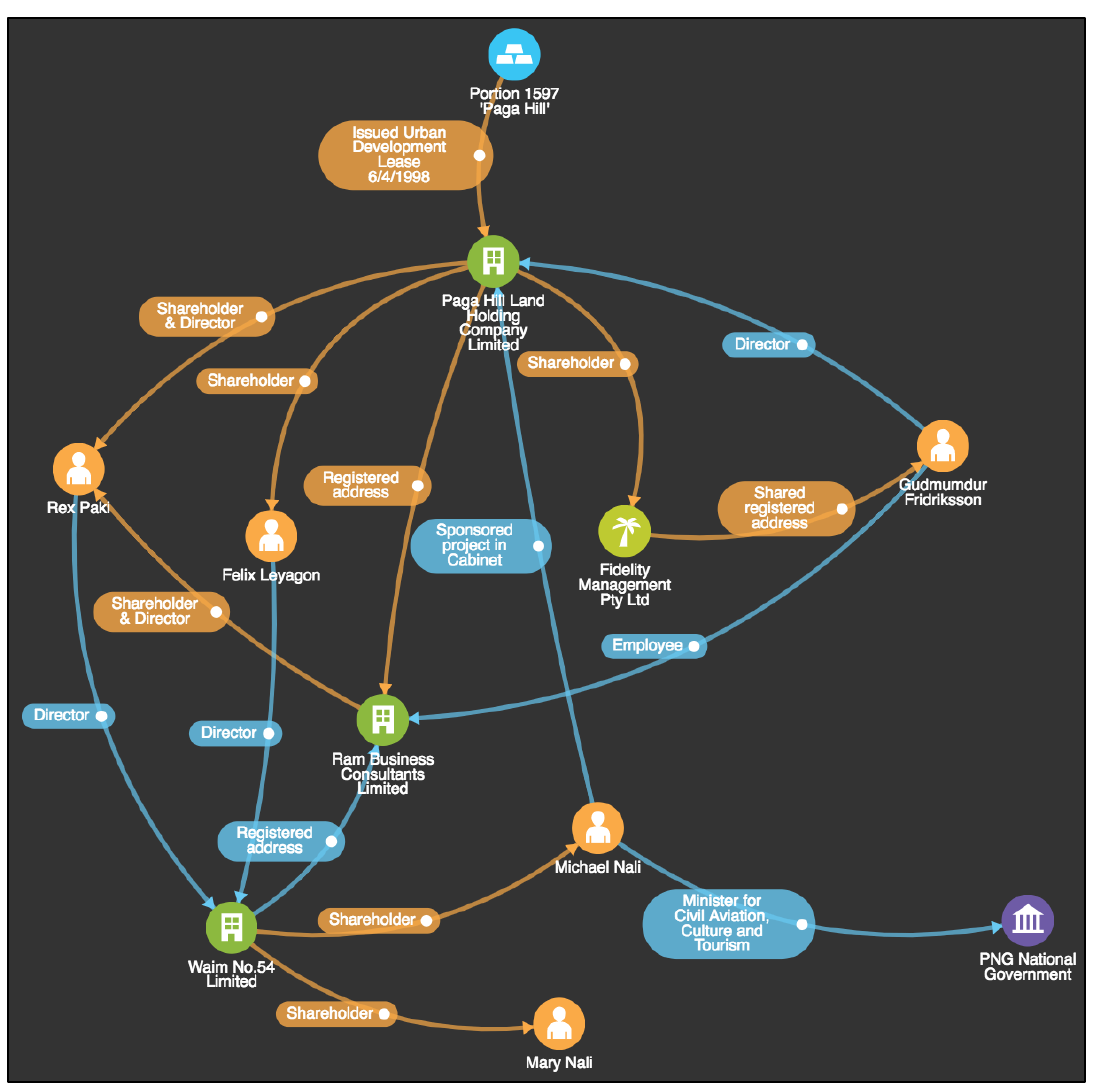
Diagram 4: The Paga Hill Land Holding Company Limited 1998 network Source: Investment Promotion